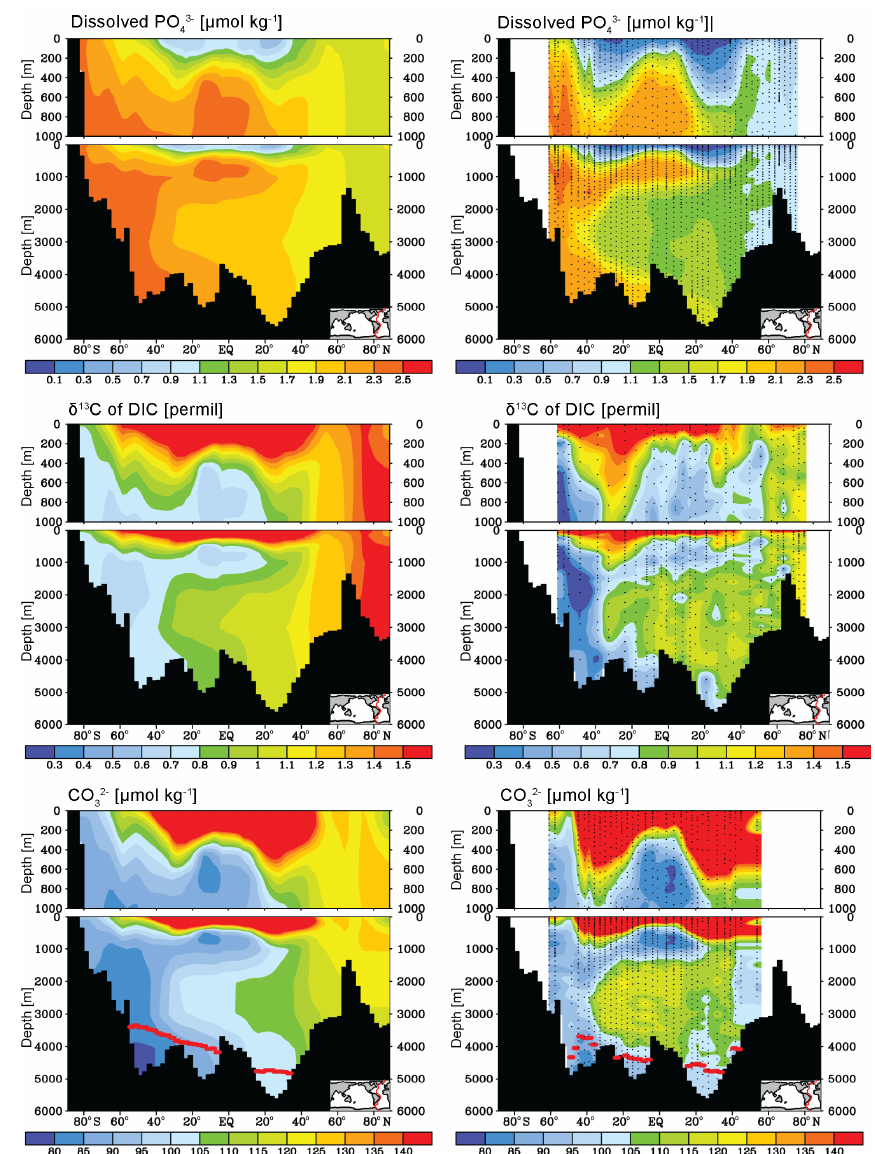
Figure 2. Atlantic Ocean cross sections for the model control run (left column) and observations from the GEOSECS programme (Bain- bridge, 1981) (right column). Top: dissolved phosphate. Centre: δ 13 C of total dissolved inorganic carbon. Bottom: carbonate ion concentra-